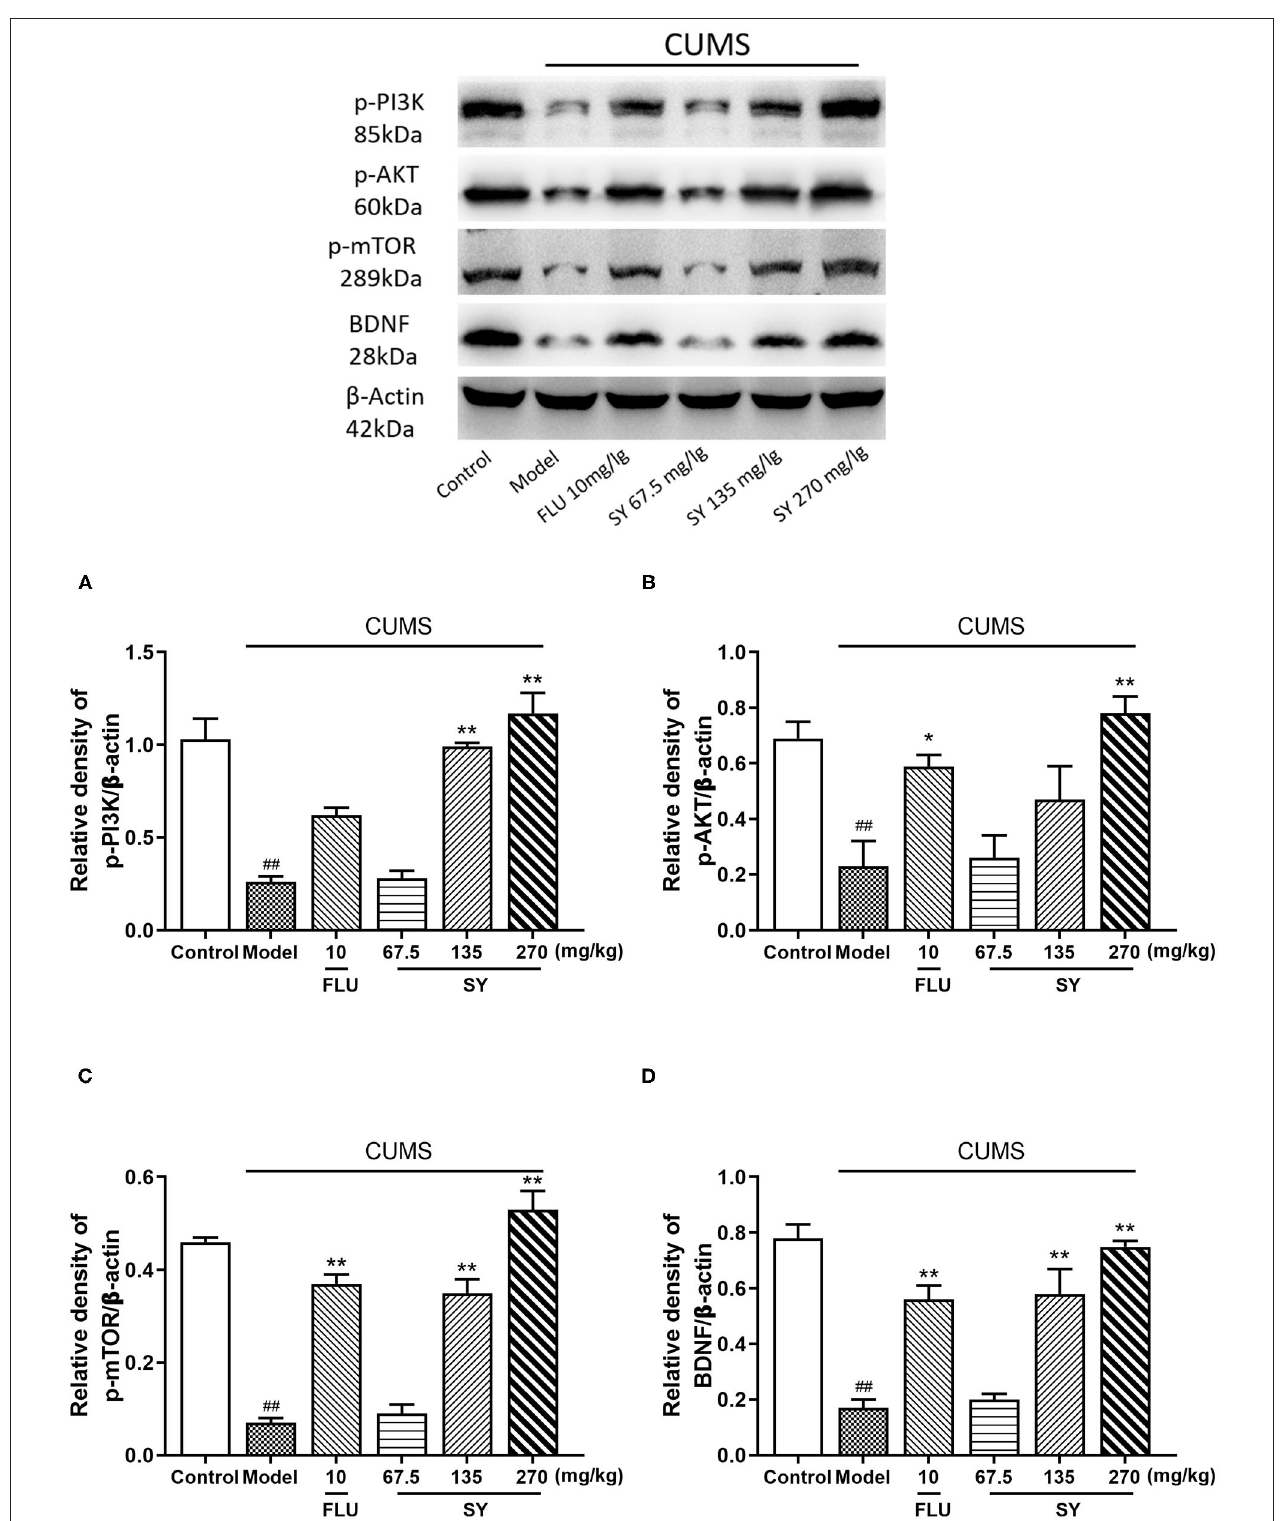
FIGURE 6 | Effects of SY on the hippocampal expression of p-PI3K, p-AKT, p-mTOR, and BDNF in CUMS rats. (A) Levels of p-PI3K. (B) Levels of p-AKT. (C) Levels of p-mTOR. (D) Levels of BDNF in each group. Data represent the mean ± S.E.M. ( n = 10 per group). ## p < 0.01, vs. the control group; * p < 0.05, ** p < 0.01 vs. the CUMS